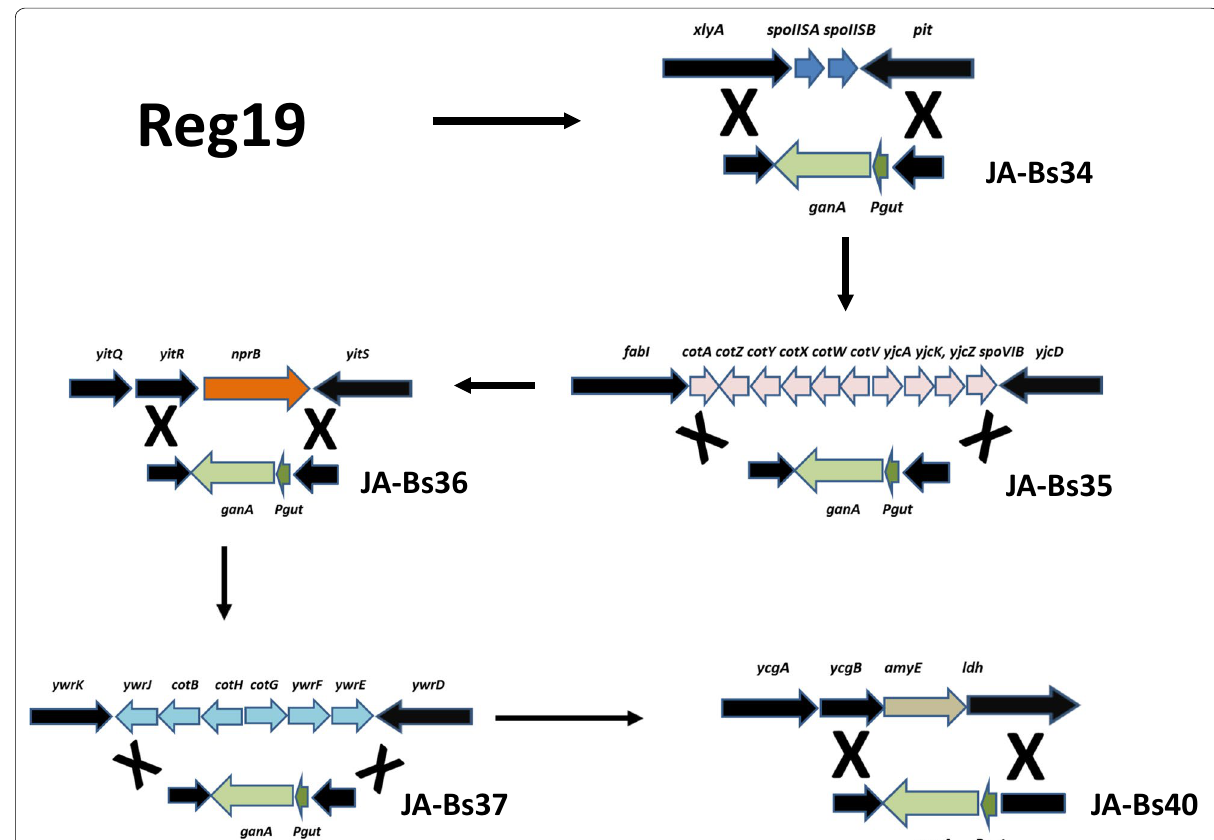
Fig. 2 Diagram showing the various sites of integration of the P gut - ganA cassette, the genes deleted during the integration and genes enabling integration via homologous recombination